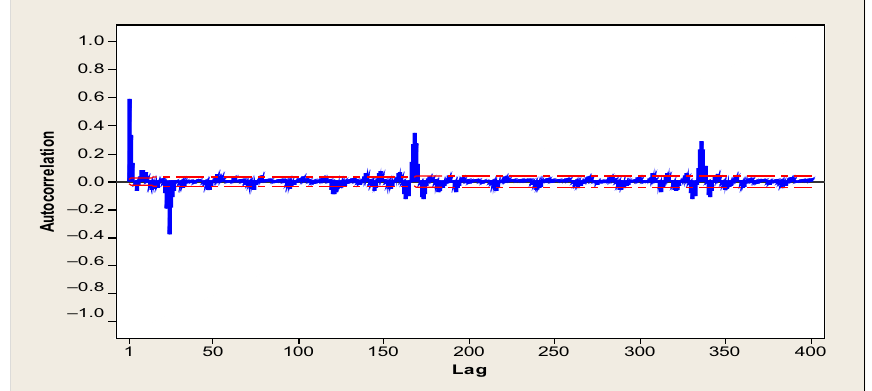
daily differencing Lag